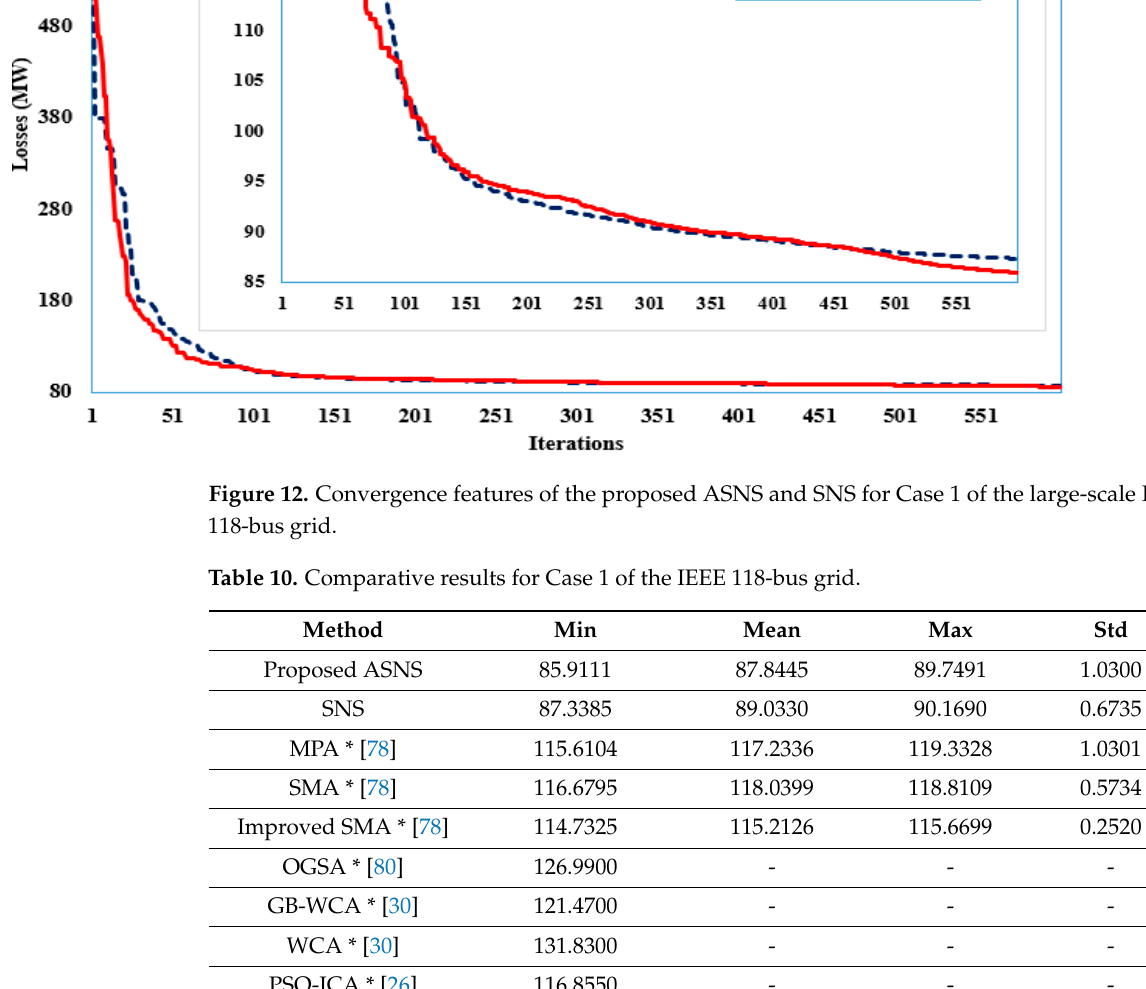
Table 10. Comparative results for Case 1 of the IEEE 118-bus grid.